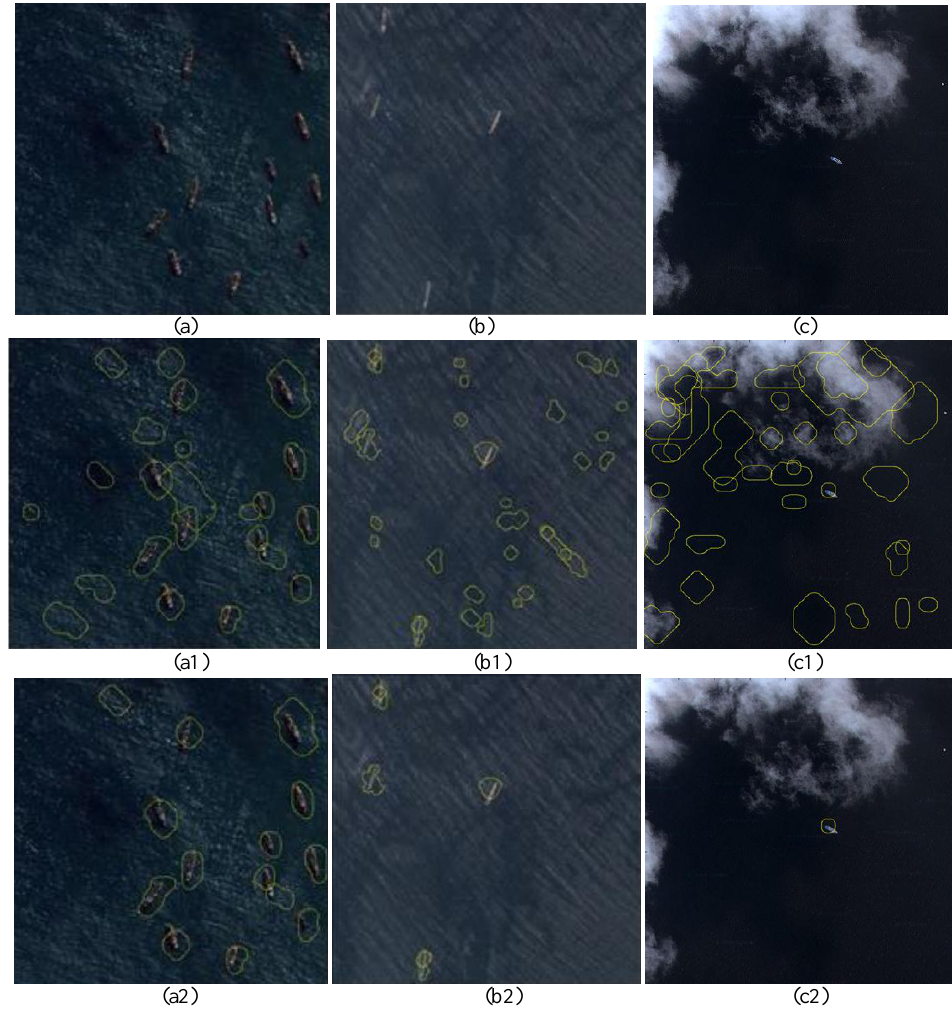
Figure 4. Single ship detection